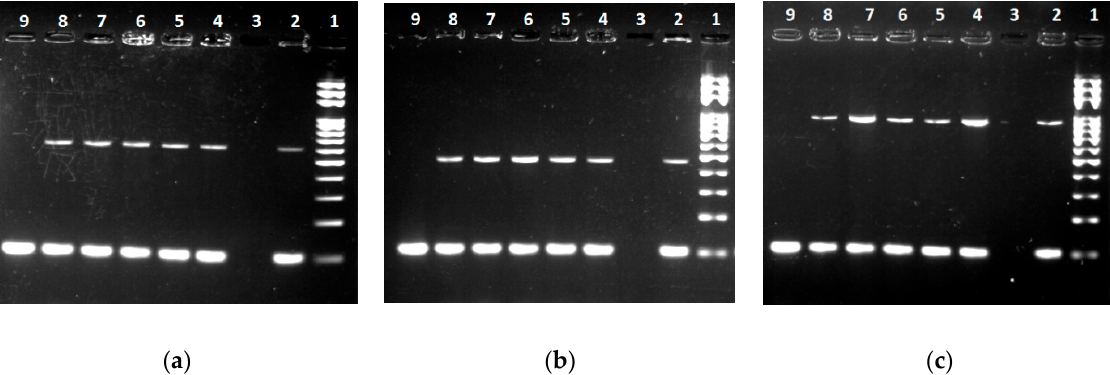
Figure 6. Electrophoretic analysis of amplicons of Penicillium ( P. ) isolates from table eggs by conventional PCR. ( a ) P. verrucosum : Line 1: 100 bp ladder standard; Line 2: P. verrucosum (ATCC ® 44407 ™ ); Line 3: negative control; Lines 4 to 8: isolates of P. verrucosum (607 bp); Line 9: 18S rRNA internal control (99 bp); ( b ) P. commune : Line 1: 100 bp ladder standard; Line 2: P. commune (CCM F-327); Line 3: negative control; Lines 4 to 8: isolates of P. commune (464 bp); Line 9: 18S rRNA internal control (99 bp); ( c ) P. crustosum : Line 1: 100 bp ladder standard; Line 2: P. crustosum (CCM 8322); Line 3: negative